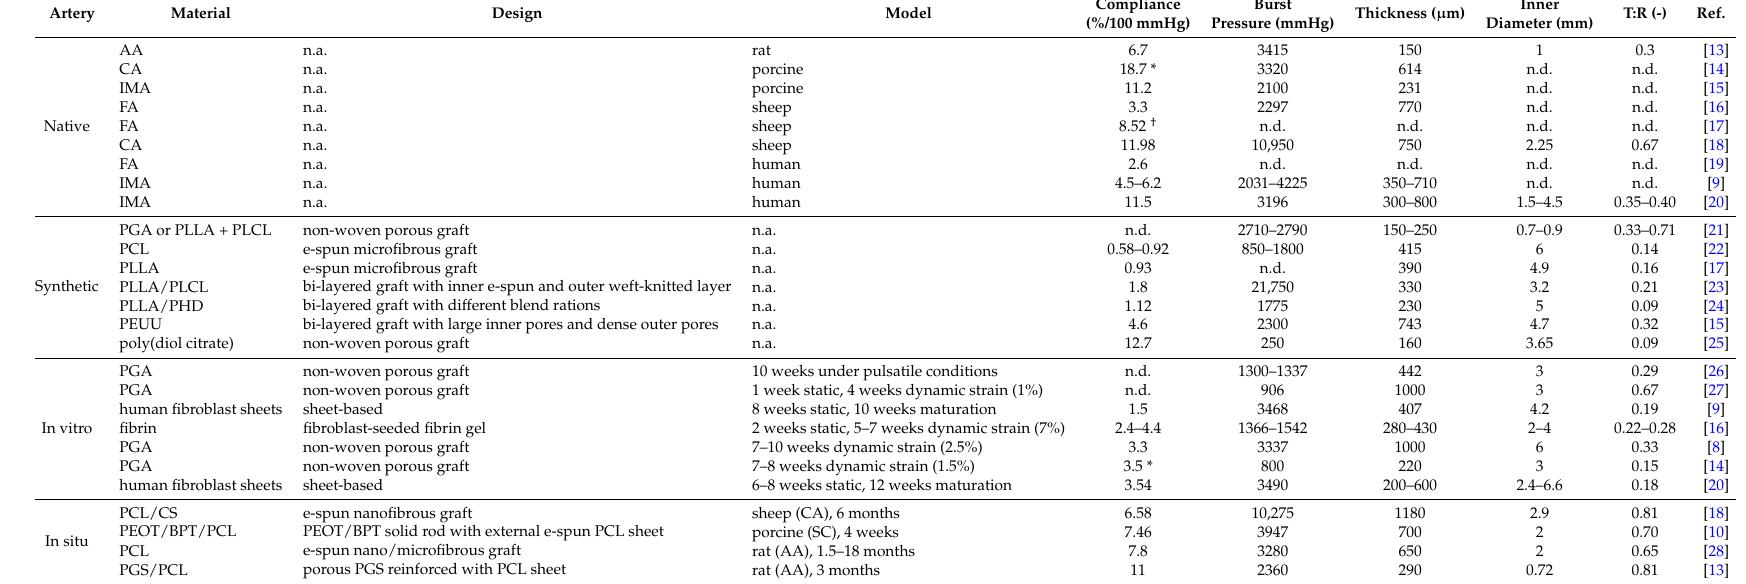
Table 1. Mechanical properties, measured in terms of compliance and burst pressure, and structural properties, measured in terms of wall thickness, inner diameter, and vessel wall thickness-to-radius (T:R) ratio, from a selection of studies concerning native tissue, synthetic grafts, in vitro tissue-engineered grafts, and in situ tissue-engineered grafts. Compliance is measured in the physiological range, i.e., 80–120mmHg, unless indicated